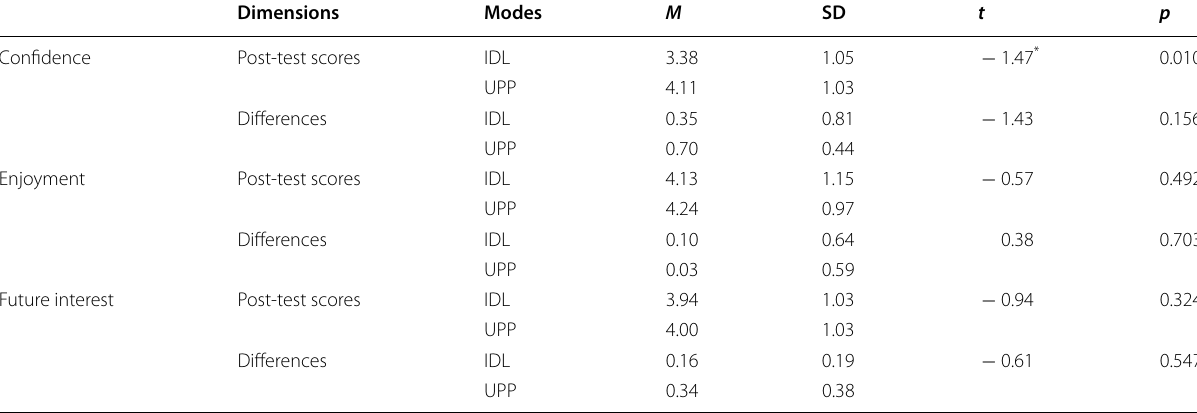
Table 4 Independent t test of post-test of attitudinal findings under two instructional modes